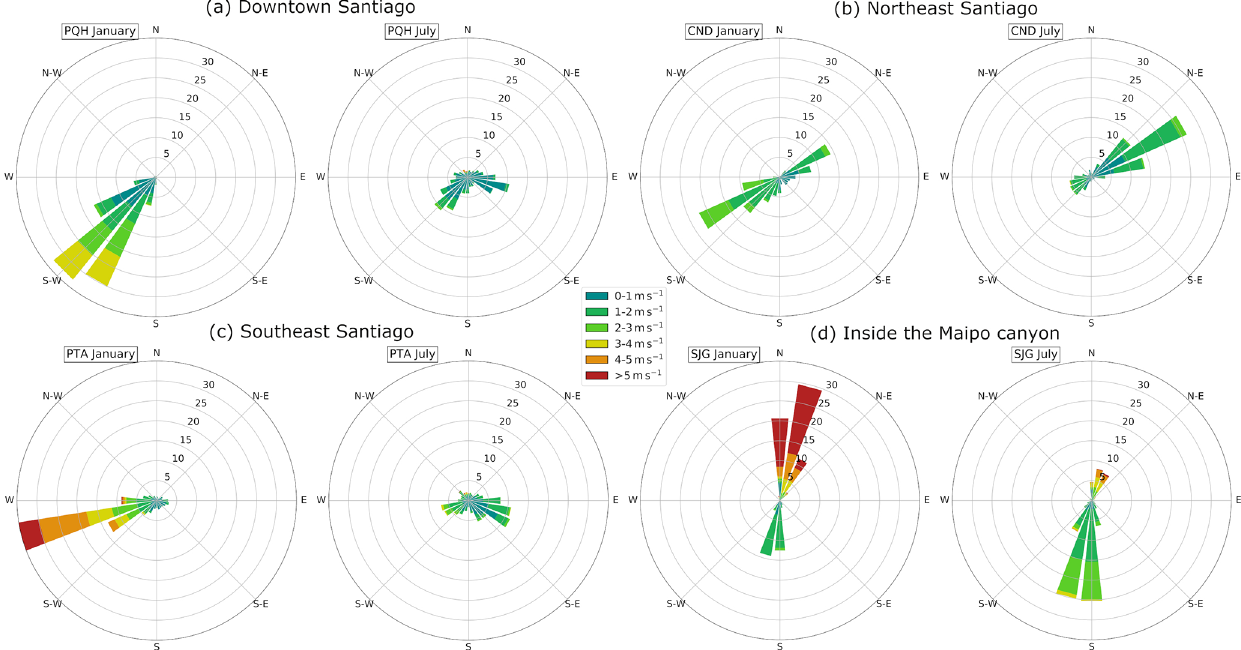
Figure 8. Wind speed and direction distribution at (a) Parque O’Higgins (PQH – downtown Santiago), (b) Las Condes (CND – northeast Santiago, near the entrance of the Mapocho canyon), (c) Puente Alto (PTA – southeast Santiago, near the entrance of the Maipo canyon), and (d) San Jose de Guayacan (SJG – deep into the Maipo canyon). Wind roses display the distribution of hourly data for January and July 2015. Source SINCA for (a–c) ; source DMC for (d)